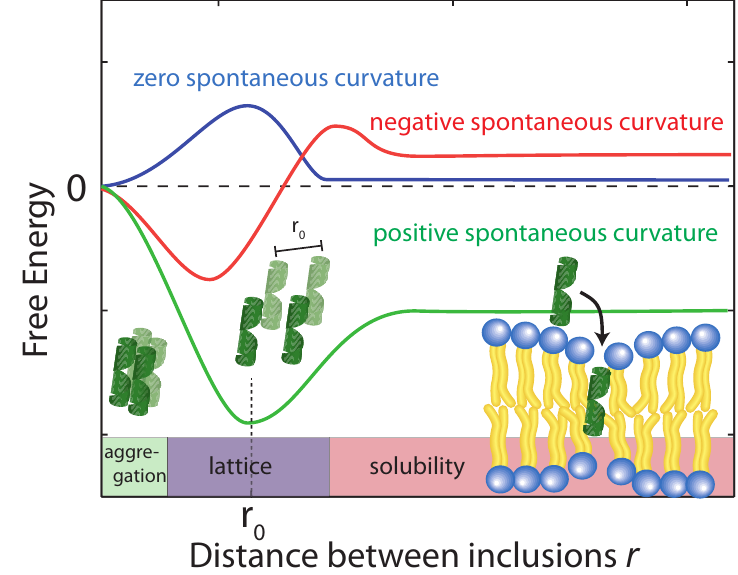
Figure 6. Schematics of the free energy profiles of lipid monolayers for lipids with zero, positive, and negative spontaneous curvature as function of the distance between inclusions. (Adapted from [21], copyright Royal Society of Chemistry,